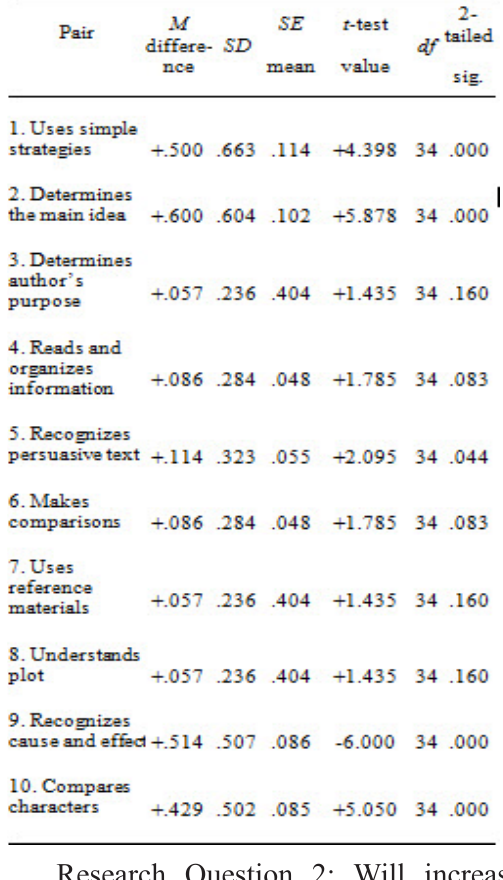
Table 2. Paired-Samples t-Tests of Sig - nificance Results